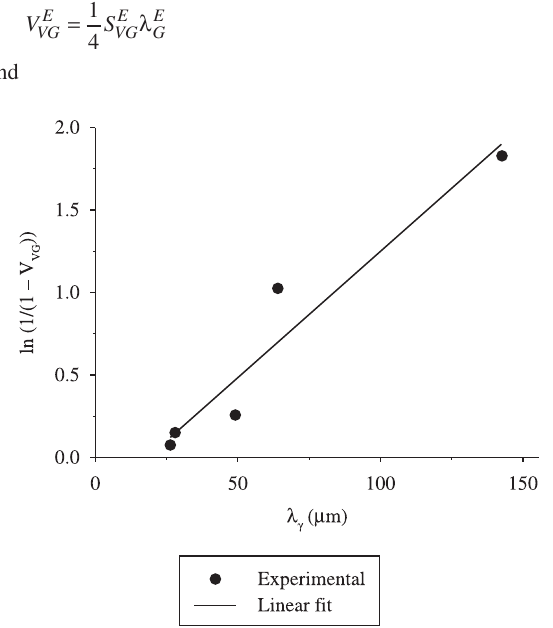
Figure 3. Plot of Equation 14 with experimental data on martensite burst, see Table 1, on a Fe-31 mass% Ni-0.02 mass% C alloy. Fitted parameters are given in Table 2.